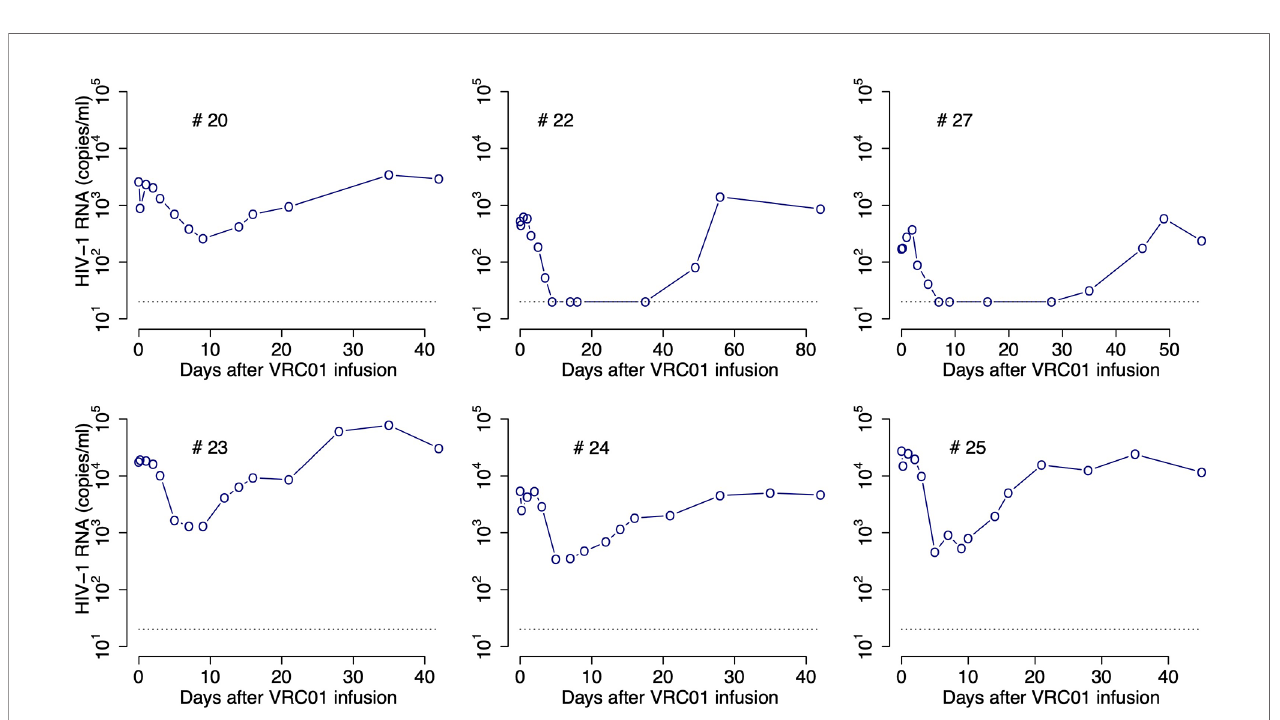
FIGURE 1 | HIV-RNA levels in plasma after infusion of VRC01. Patient identi fi ers are given at the top of each